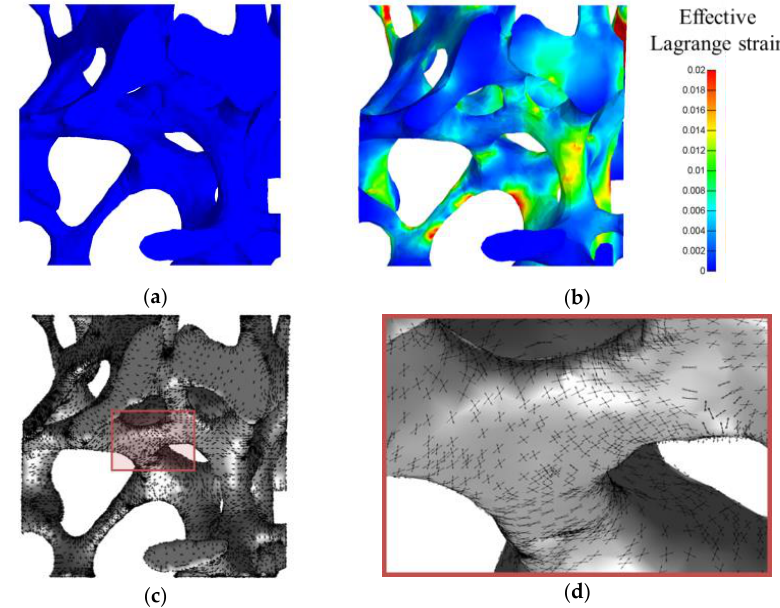
Figure 5. Computed cellular preferential directions computed at the surface of a trabecular bone sample subject to a uniaxial 1% compression test. Color code corresponds to effective Lagrange strain before ( a ) and after ( b ) the compression. Two cellular preferential directions were computed for each mesh node, as visible for the whole sample on ( c ) and for a specific trabeculae on ( d ).